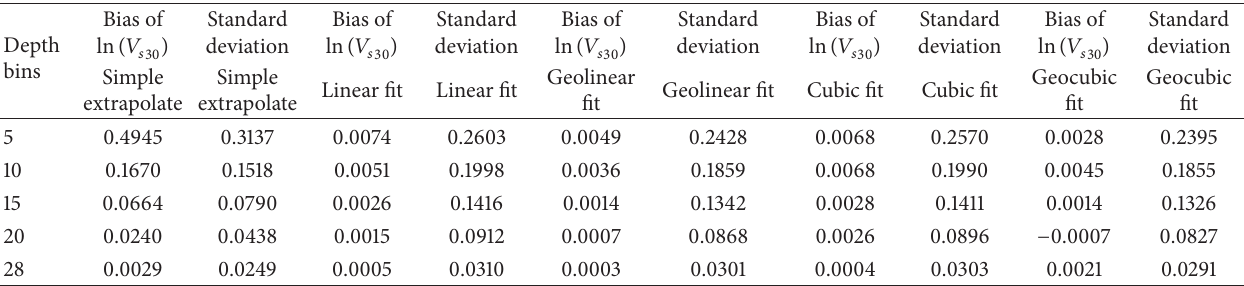
Table 4: Comparison of bias and standard deviation between the normal fit and Geo fit to Kiknet profiles.